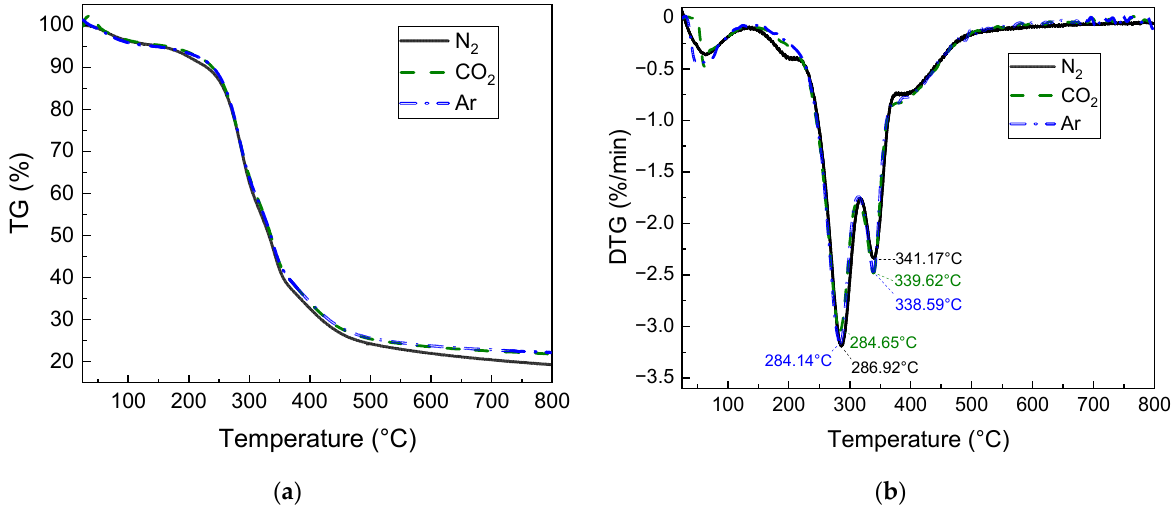
Figure 2. TG ( a ) and DTG ( b ) curves of BSG pyrolysis under nitrogen, carbon dioxide, and argon atmospheres at a heating rate of 5 K/min.